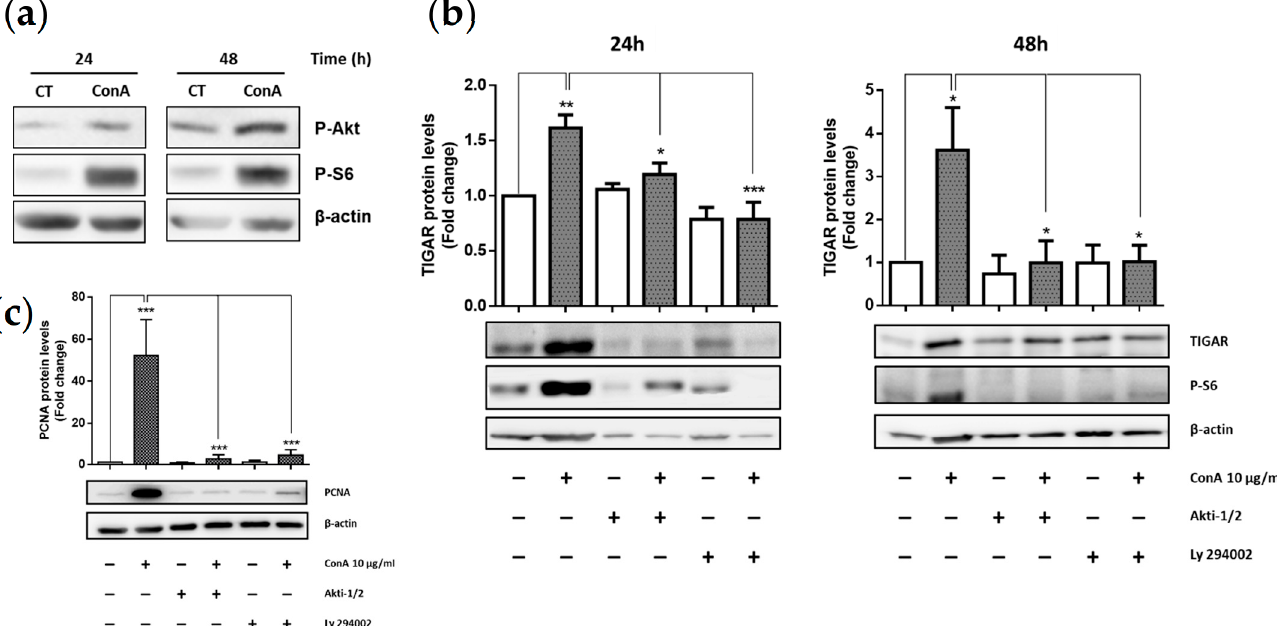
Figure 2. PI3K/Akt inhibition prevents TIGAR and PCNA induction in ConA-stimulated lymphocytes. ( a ) Western blot analysis of P-Akt and P-S6 incubated with 10 µ g/mL ConA normalized to β -actin. ( b ) Western blot analysis and quantification of TIGAR and P-S6 incubated with PI3K/Akt inhibitors (Akti-1/2 and Ly 294002) at a concentration of 10 µ M and 20 µ M respectively and normalized to β -actin. ( c ) PCNA protein levels in response to the aforementioned conditions at 48 h. All data are presented as a mean fold change relative to untreated cells ± SEM. Differences were calculated with two-way ANOVA and Tukey’s multiple comparisons test with a normal-based 95% CI. Significant p values are indicated; * p < 0.05; ** p < 0.01; *** p < 0.001, n = 3 treated with ConA.